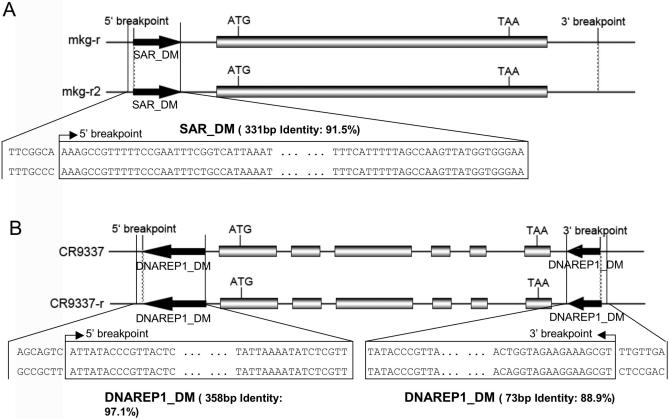
Two Examples of New Genes with Repetitive Sequences at the Breakpoints(A) Shows a satellite DNA sequence (SAR) located at the 5′ breakpoints of mkg-r2 and its parental gene mkg-r.(B) Shows the existence of a transposon (DNAREP1-DM) at all the four breakpoints of a CR9337 duplicate pair.